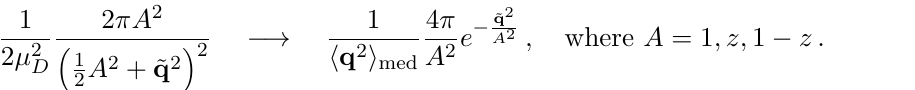
We now ask to what extent the resulting